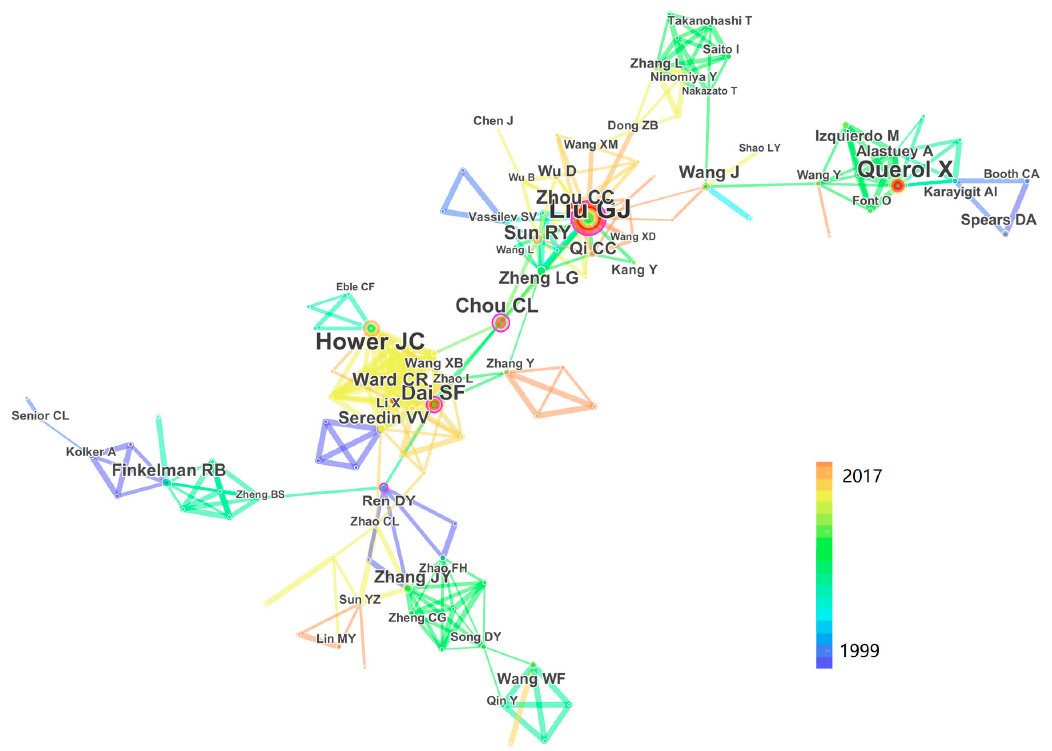
Figure 2. The co-occurrence of productive authors of trace elements in coal and ash. The different colors display the different year of the first cooperation between the authors. The size of the pot displays the number of cooperative studies of co-occurrence authors.